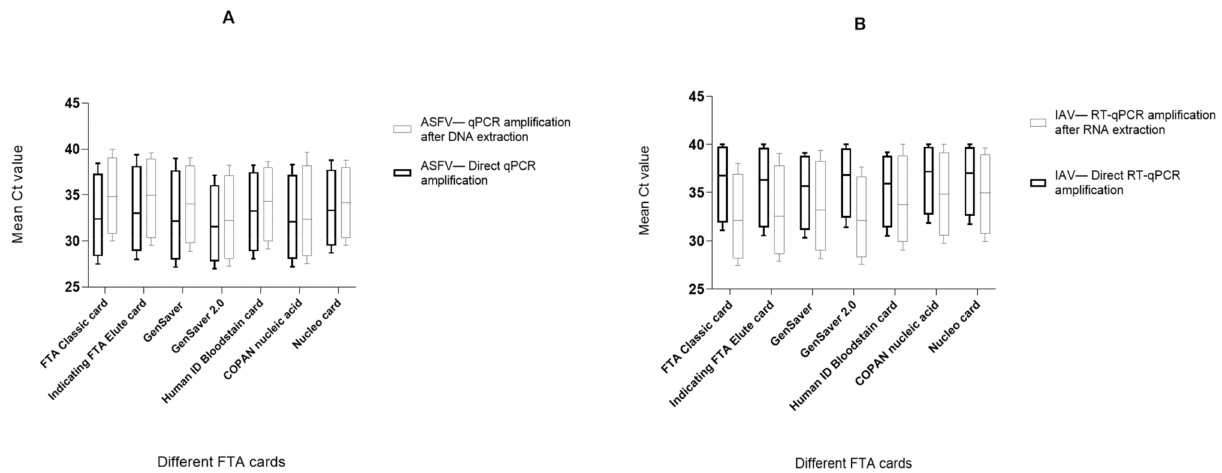
Figure 2. ( A ) Direct qPCR amplification with and without nucleic acid extraction for ASFV detection. The mean Ct values based on different FTA cards. SD analysis was carried out (number of replicates = 7, Supplementary Table S2) are shown. Standard deviation (SD) value for all cards by the direct qPCR amplification is 0.78 and for qPCR amplification with extraction is 1.14. The standard error of the mean value for all methods by direct amplification is 0.29 and for the amplification with extraction is 0.43. An unpaired multiple t -test was performed to test the significance between the different FTA cards based on both the qPCR amplification direct and with extraction with a resulting p -value > 0.99 for the taken values, which is not statistically significant. ( B ) Direct RT-qPCR amplification with and without nucleic acid extraction for IAV detection. The mean Ct values are based on different FTA cards. SD analysis was carried out (number of replicates = 7, Supplementary Table S2) are shown. Standard deviation (SD) value for all cards by the direct RT-qPCR amplification is 0.76 and for RT-qPCR amplification with extraction is 1.74. The standard error of the mean value for all methods by direct amplification is 0.28 and for the amplification with extraction is 0.55. An unpaired multiple t -test was performed to test the significance between the different FTA cards based on the both RT-qPCR amplification direct and with extraction with a resulting p -value > 0.99 for the taken values, which is not statistically